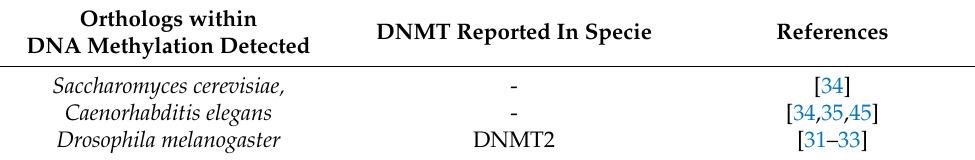
Table 2. Species without DNA methylation